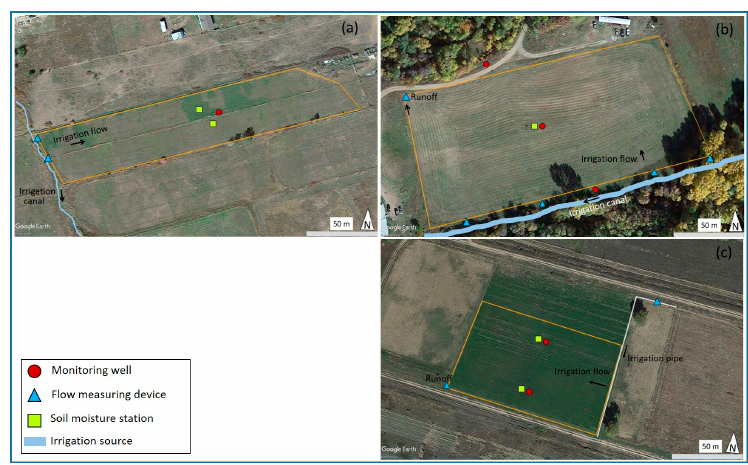
Figure 3. Monitoring instrumentation layout at the three different sites, ( a ) El Rito; ( b ) Rio Hondo; and ( c ) Alcalde.